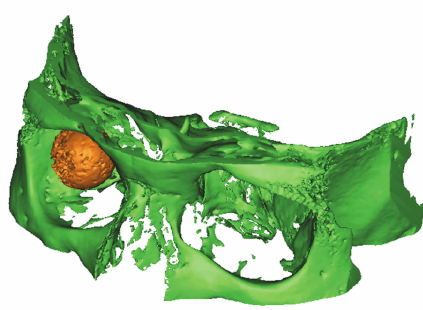
Figure 7: Volume rendering of the dedicated orbital volume (DV). The DV is illustrated (green) and the orbital implant (yellow).